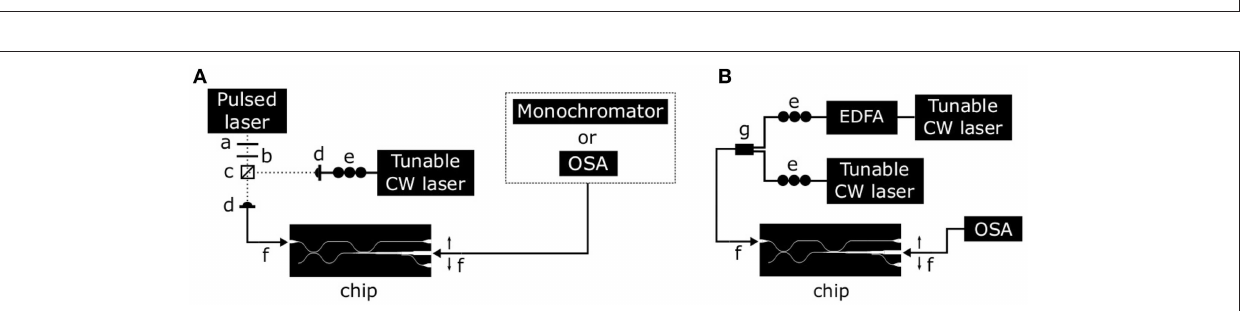
FIGURE 4 | (A) Cross-section for the 3dB-DC. (B) Cross-section for the ADC. (C) FEM simulation of the 3dB-DC at 1.55 µ m wavelength, with w 1 = w 2 = gap = 0.6 µ m , L coupl = 20.269 µ m . (D) FEM simulation of the ADC for the 2TE mode coupling at 1.55 µ m wavelength, with w 1 = gap = 0.6 µ m , w 2 = 1.489 µ m , L coupl = 75.613 µ m . (E) Optical image of the fabricated ADC. This ADC corresponds to the one simulated in (D) .